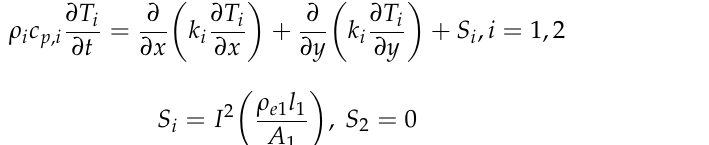
where k , σ ( t ) , and T are the thermal conductivity, electrical conductivity of silver nanoparti- cles, and temperature, respectively. The Lorentz number of silver, L silver , is 2.44 × 10 − 8 [36]. The electrical conductivity is the reciprocal of the specific resistance. We obtained the electrical conductivity by the in situ measurement of line resistance, and subsequently, the thermal conductivity via Equation (2). When comparing Equations (1) and (2), we observe that the information regarding the change in the NP cross-sectional area is required in the numerical model for estimating the thermal conductivity-dependent temperature. However, since the area shrinkage when the NPs are thermally treated for short times is negligible based on the previous study by oven sintering [37], therefore considering a fraction of time taken during the electrical sintering compared to oven sintering, we assumed that the area shrinkage remained constant throughout the sintering process. The two-dimensional heat conduction equation is as follows: